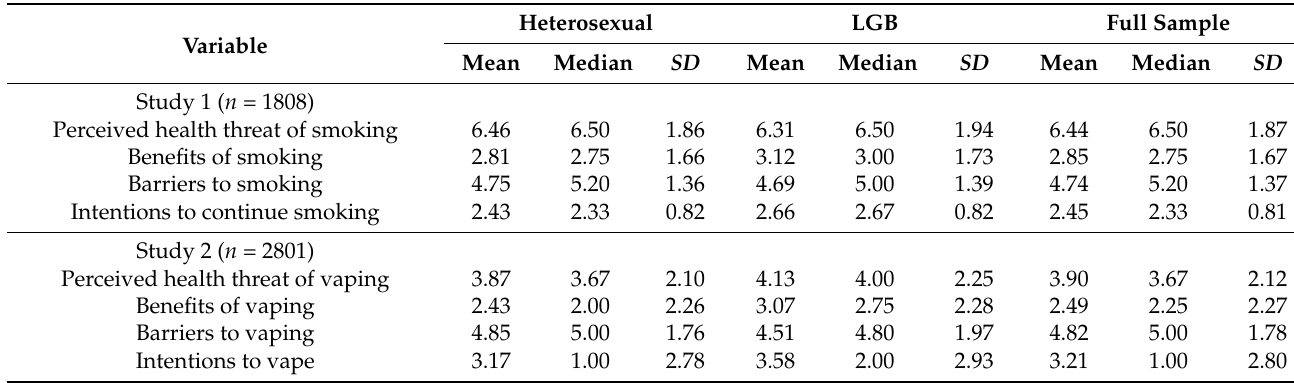
Table 2. Variable Means and Standard